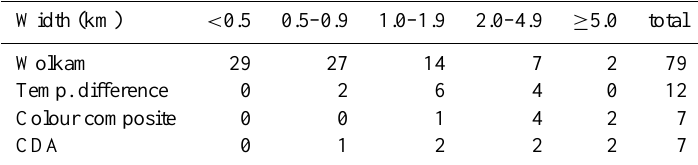
Table 4. Comparison of contrail detection in Wolkam and MSG/SEVIRI data as a function of their width.